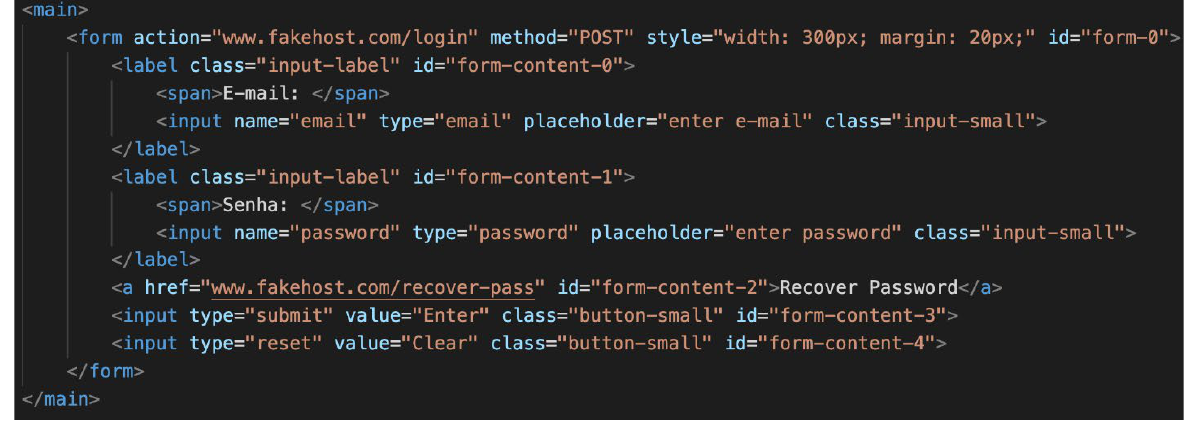
Figure 13. HTML code generated for the implementation of the getMainObjects function returning a login form. The id property value is generated automatically for each form input, so this the Acceasy can position them using CSS